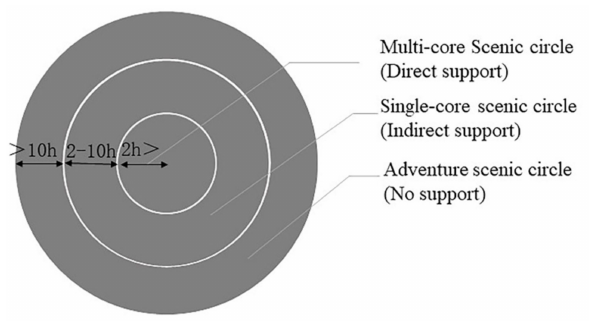
Figure 3. The core-edge support circle of tourist attractions and